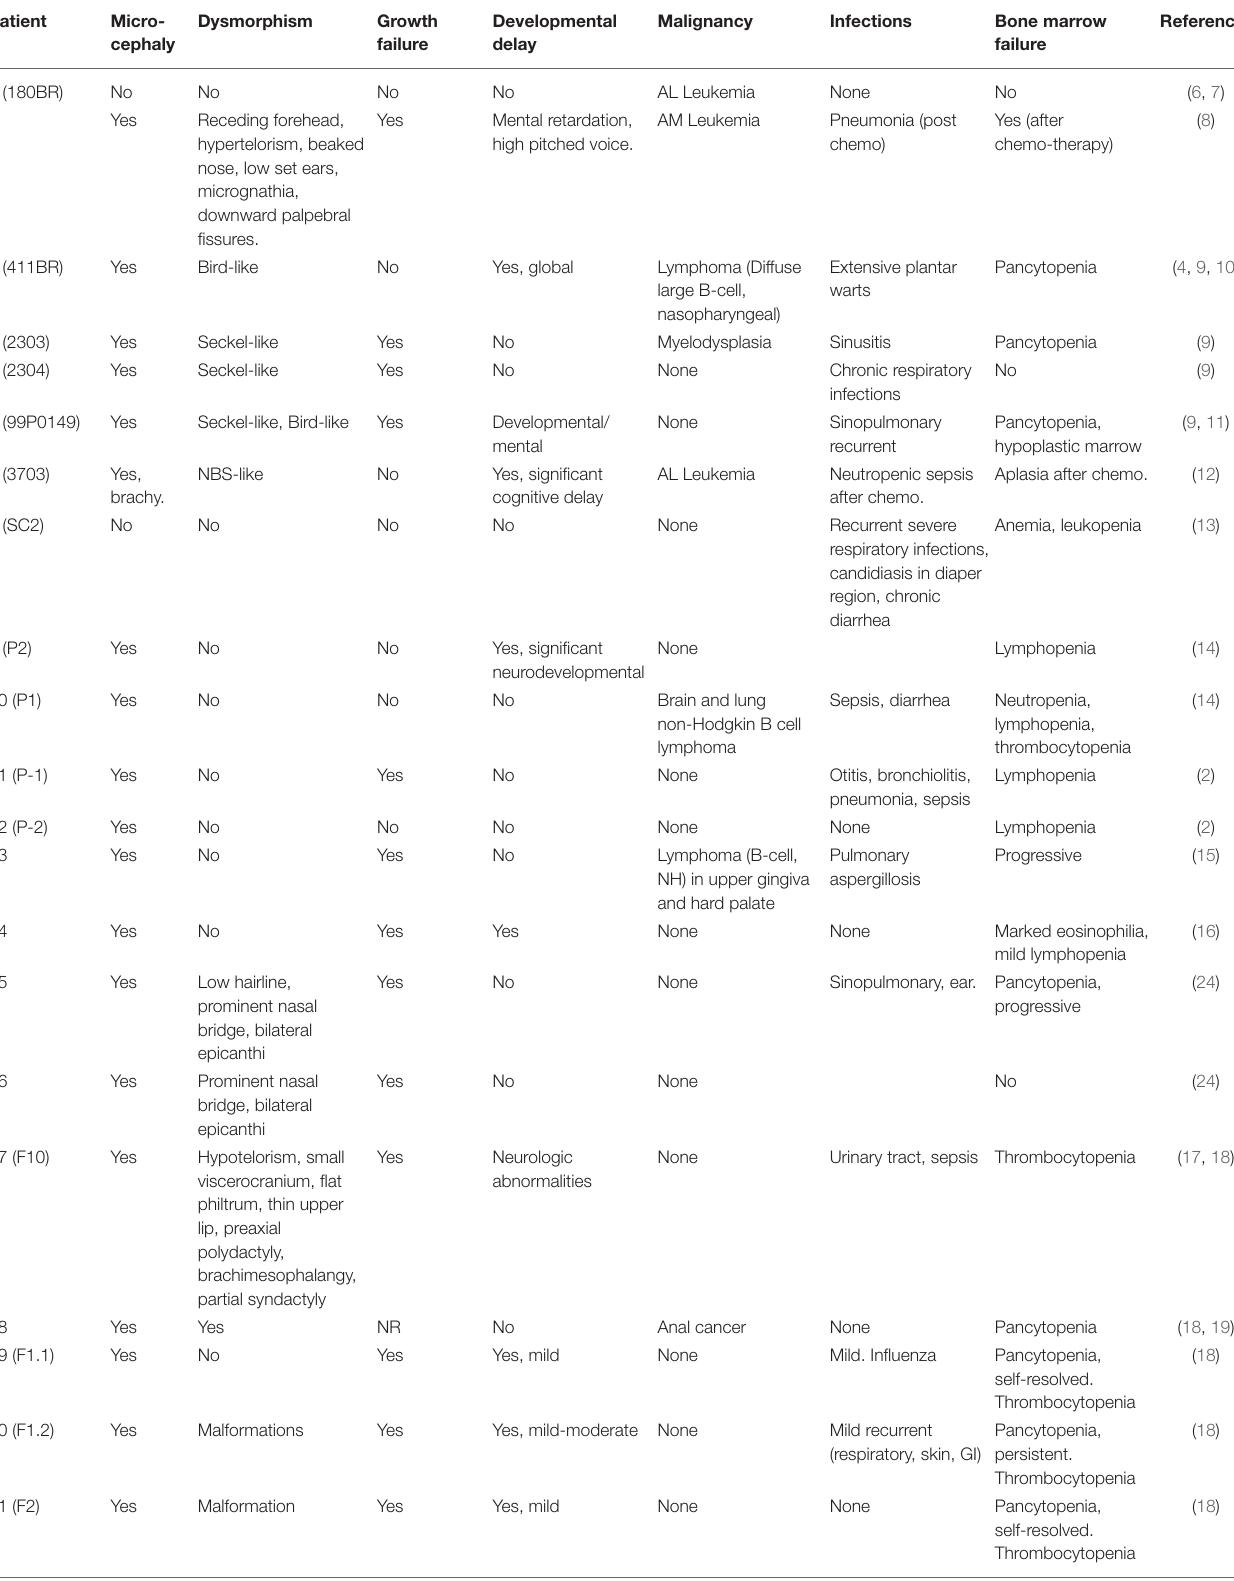
TABLE 2 | Key features of published patients with LIG4 deficiency.